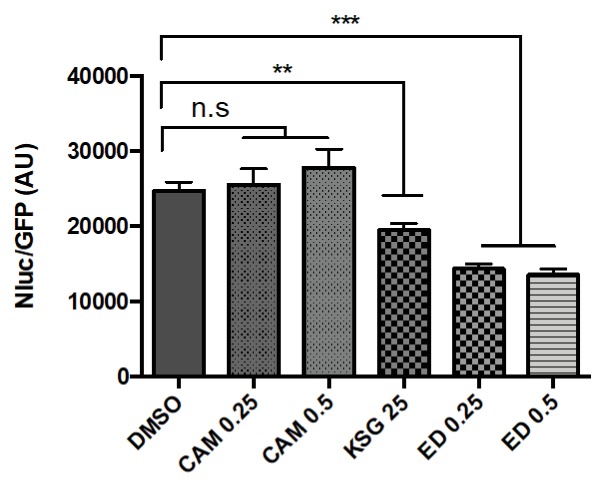
The 30S initiation inhibitors edeine and kasugamycin decrease Asp-tRNAAsn mistranslation rates.Mistranslation was measured in Msm by the Nluc/GFP reporter as in Figure 1(A–C). SubMIC concentrations of antibiotics – chloramphenicol (CAM – 0.25–0.5 µg/ml), kasugamycin (Ksg, 25 µg/ml) and edeine (ED – 0.25–0.5 µM) were used in the assay. **p<0.01, ***p<0.001, n.s. no significant difference by Student’s t-test.